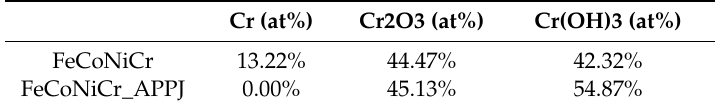
Table 7. XPS Cr2p deconvoluted peak areal ratios from XPS spectra shown in Figure 11.